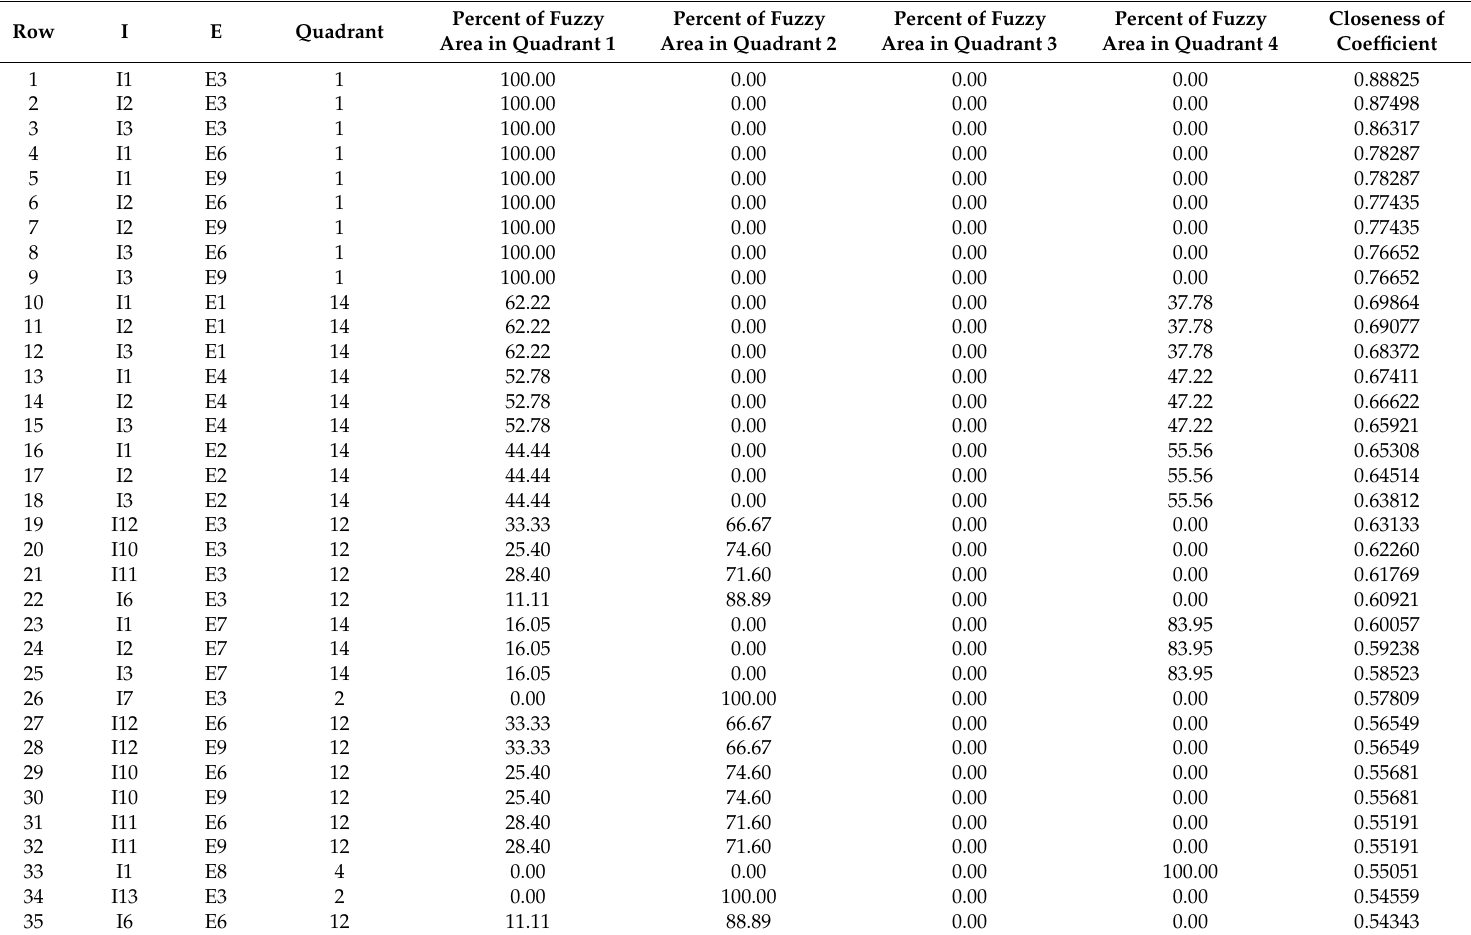
Table 4. Prioritization, α =